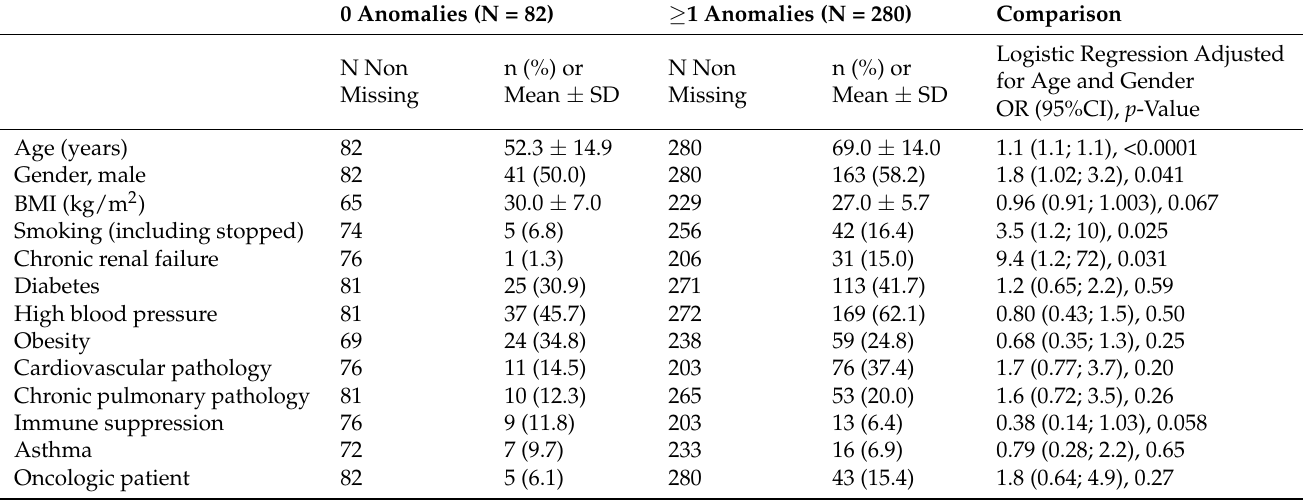
Table A1. Patients’ description in function of the presence of pre-existing or newly identified anomalies on CT scan (N =